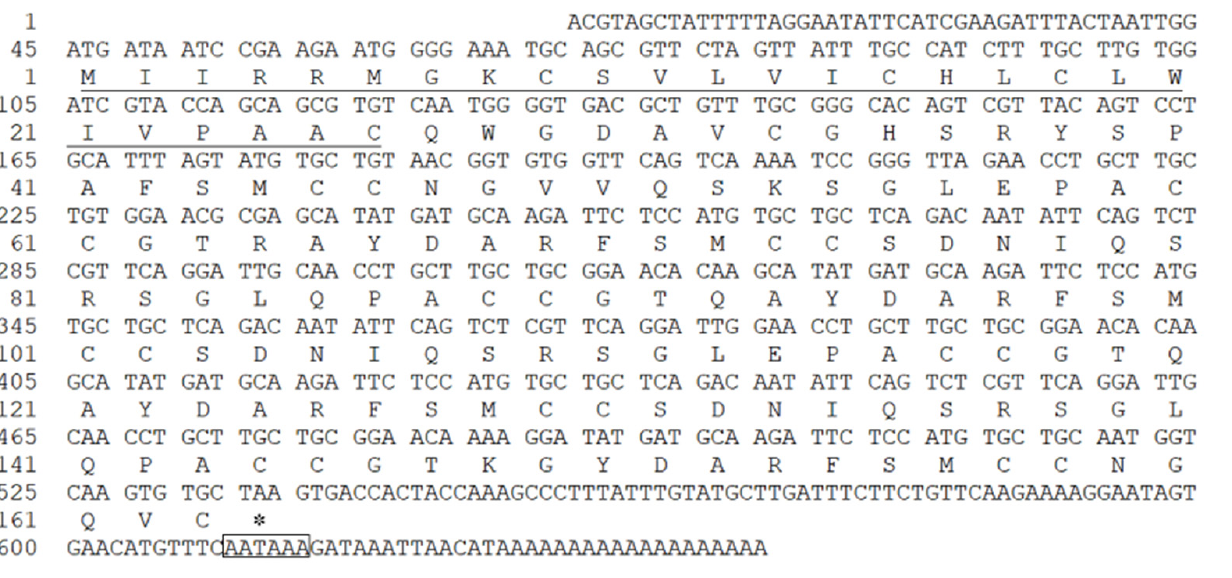
Figure 1. The cDNA and deduced amino acid sequence of cysrichin. Note: the underlined sequence represents a putative signal peptide; the boxed sequence is a putative polyadenylation signal (AATAAA); the cDNA sequence has been deposited in GenBank (Accession No.: MN829946).